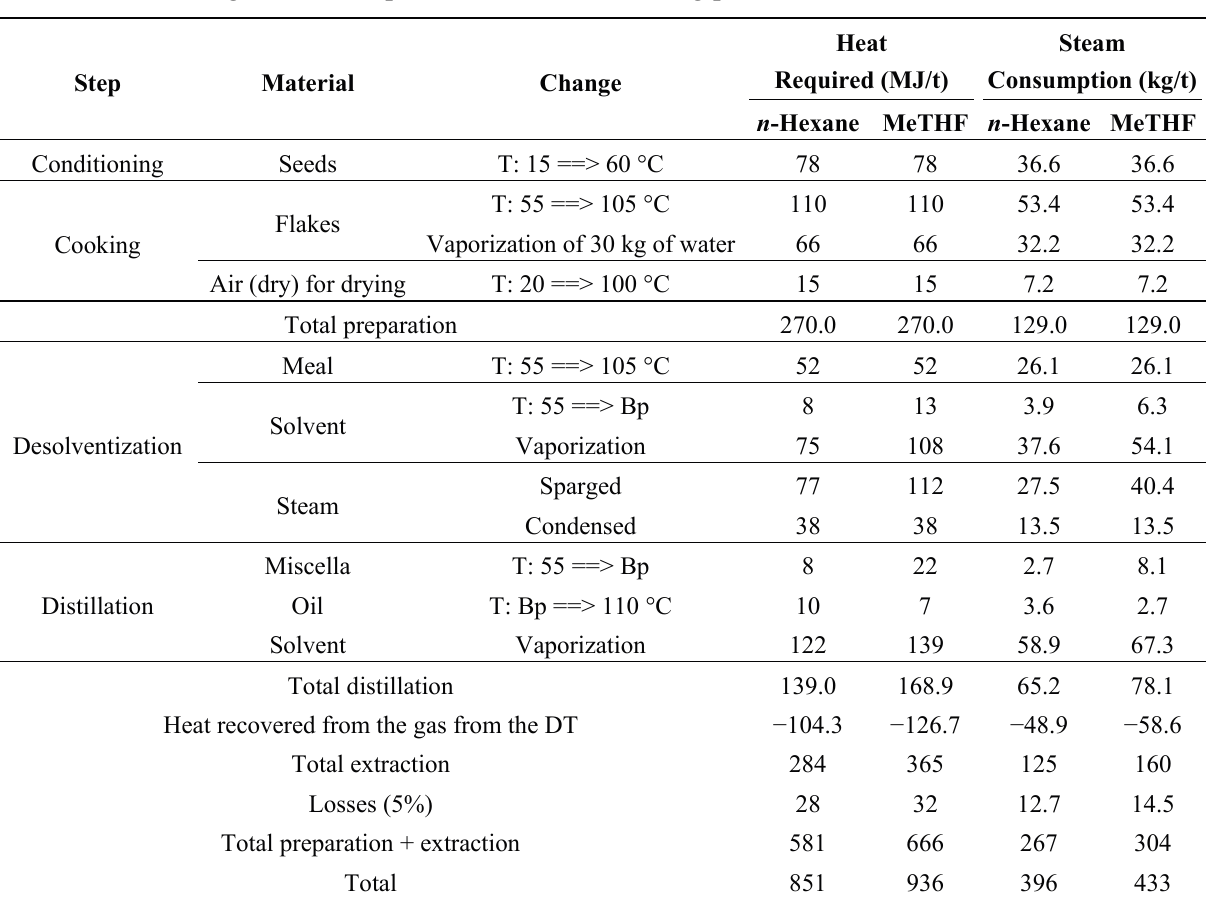
Table 7. Energetic consumption for the total crushing process with n -hexane and